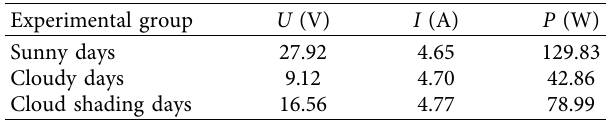
Table 5: Maximum power point computation under three different real-weather